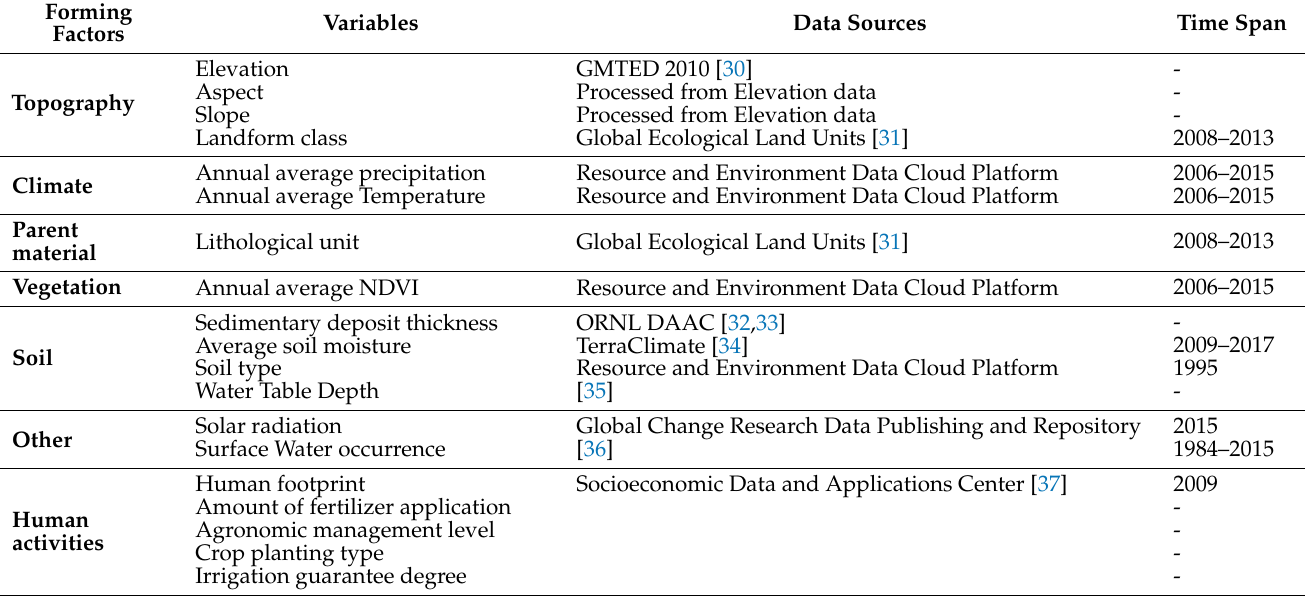
Table 1. Covariates used in the study and their